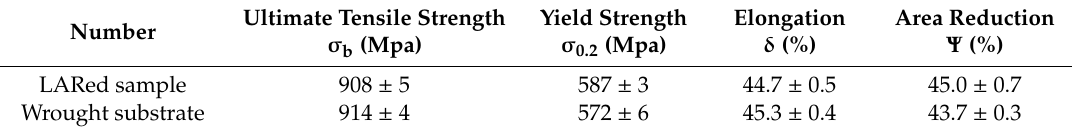
Table 3. Room temperature tensile properties of wrought and LARed Inconel 625 alloy